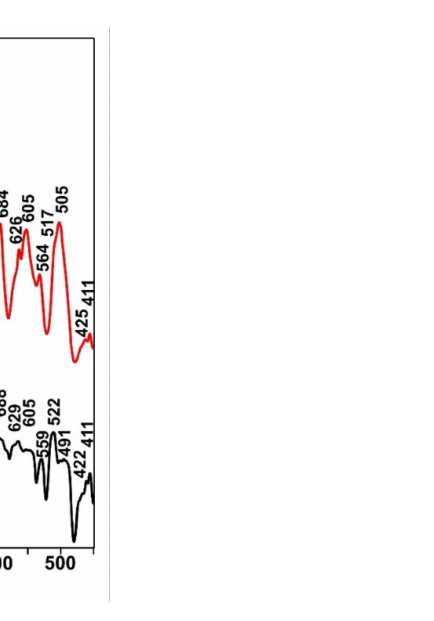
Figure 9. MIR spectra of PEEK powder ( a ) and the n-HA/ZnS/S-PEEK coating heated at 450 ◦ C ( b